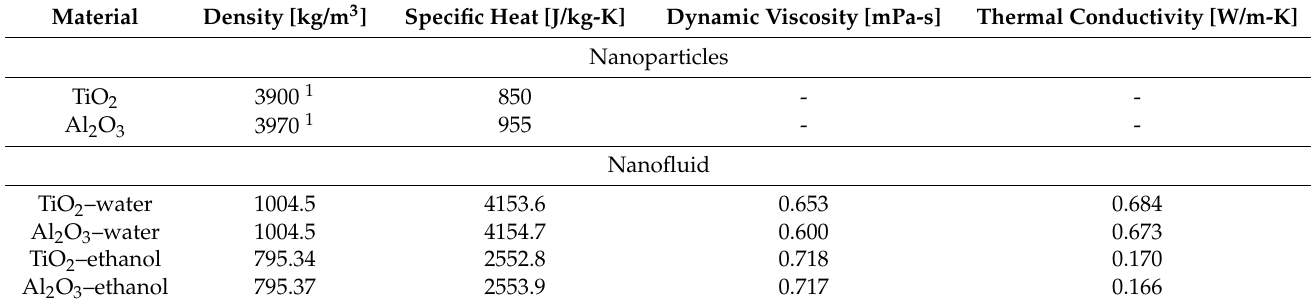
Table 2. Summary of nanofluid